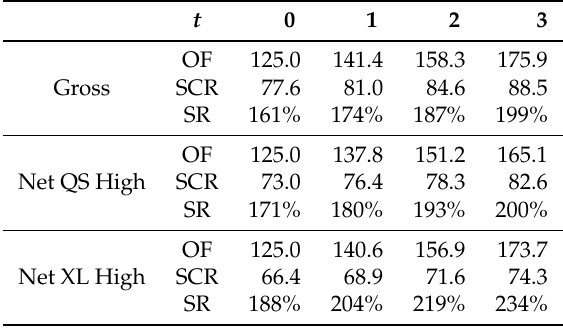
Table 11. SR for Tau during the following 3 years (amounts in mln of Euro) (Motor Ptf—10% GL).